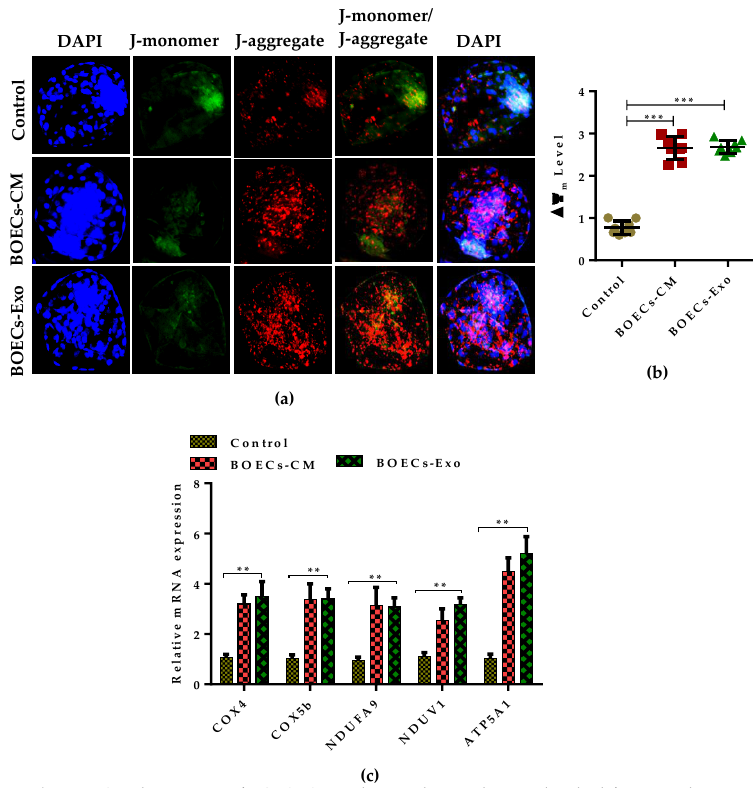
Figure 6. Supplementation of BOECs-CM and Exo enhances the mitochondrial functions during bovine embryonic development. ( a ) Fluorescence confocal microscopy images of the JC-1 staining, showing the mitochondrial ∆ Ѱ m detected by the presence of J-monomer (green) and J- aggregates (red) in control, BOECs-CM, and Exo groups. Nuclei stained in blue. Original magnification 100 × . ( b ) Quantification for relative fluorescence intensities were presented in graph. BLs ( n = 20) analyzed per group in triplicate sets of each experiment. ( c ) Relative mRNA expression profile of mitochondrial OXPHOS subunit and ATP synthesizing genes analyzed in day-8 BLs cultured in the absence or presence of BOECs-CM and 3% Exo. ** p < 0.01; *** p < 0.001 represents significant difference.